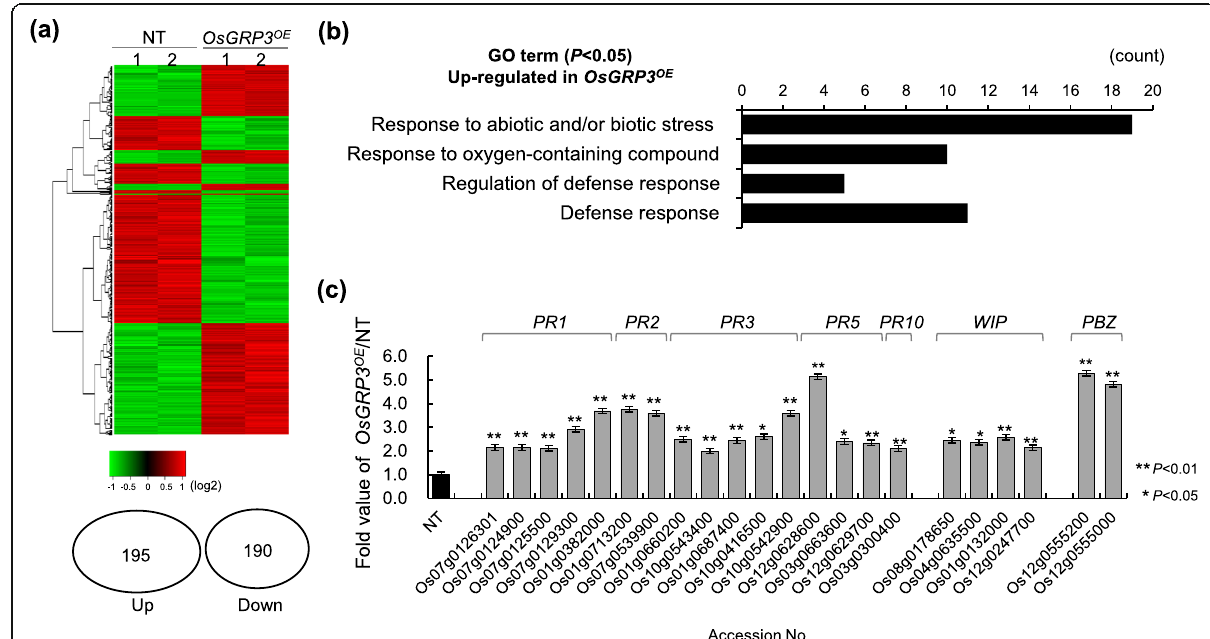
Fig. 4 Identification of differentially expressed genes by OsGRP3 overexpression. RNA sequencing analysis were performed using RNAs extracted from two-week-old non-transgenic (NT) and OsGRP3 overexpressing ( OsGRP3 OE ) transgenic plants. a Heat map analysis of differentially expressed genes (DEG) between NT and OsGRP3 OE transgenic plants. Van diagram indicates the number of up- and down-regulated DEGs in OsGRP3 OE plants than NT plants. b Gene ontology (GO) analysis of the up-regulated genes in OsGRP3 OE transgenic plants. c Fold increase the value of the up-regulated genes classified as biotic stress and defense categories through GO analysis. Data represent the mean value ± standard deviation (SD) ( n = 2, biological replicates). Asterisks indicate a statistically significant difference compared with NT. * P < 0.05, ** P < 0.01; Student